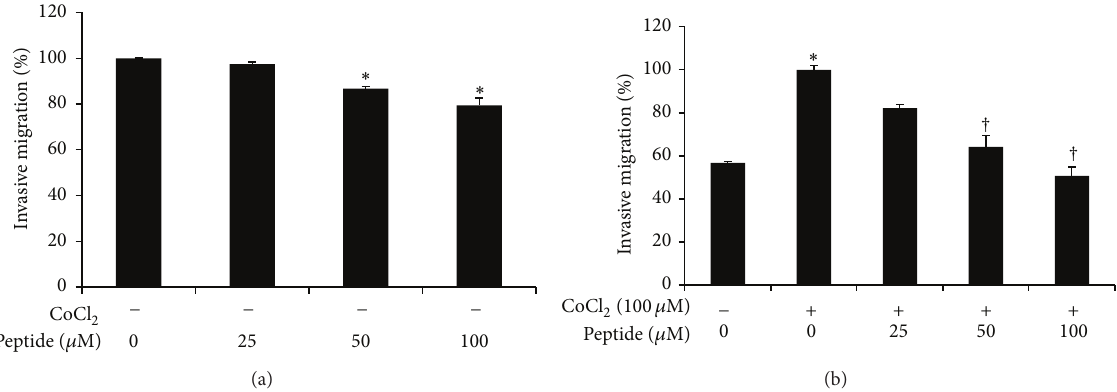
Figure 1: S. maxima peptide decreases CoCl 2 -induced invasive migration of HT1080 cells. HT1080 cells were serum starved in DMEM containing 0.1% bovine serum albumin (DMEM-BSA) for 24 h and precultured in the presence or absence of 100 𝜇 M CoCl 2 and/or various concentrations of S. maxima peptide for 24 h, transferred onto Matrigel-coated transwell membranes, and further incubated for 16h under preculture conditions. Migrated cells on the lower surface of the membrane were fixed, stained, and counted. Cells in 9 randomly selected fields were counted in each experiment. Results of at least 3 independent experiments were averaged. All data are presented as mean ± S.D. ∗ 𝑃 < 0.05 compared with blank; † 𝑃 < 0.05 compared with CoCl 2 control.